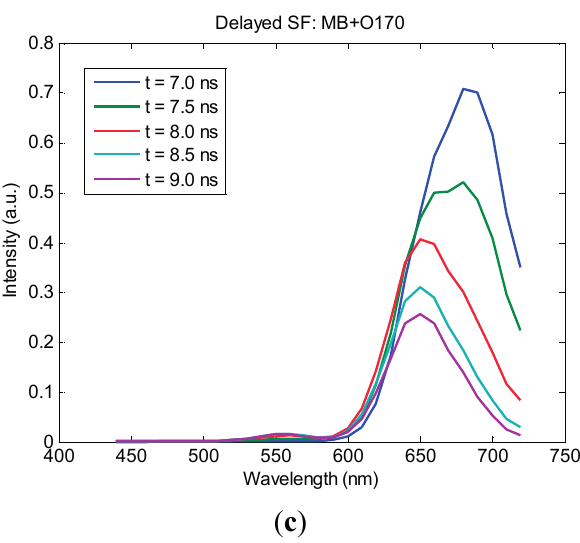
Figure 6. Time-delayed SF (“Delayed SF”) plots derived from the TRSF data set of ( a ) methylene blue (MB); ( b ) oxazine 170 (O170); and ( c ) the mixture of the two fluorophores (MB +